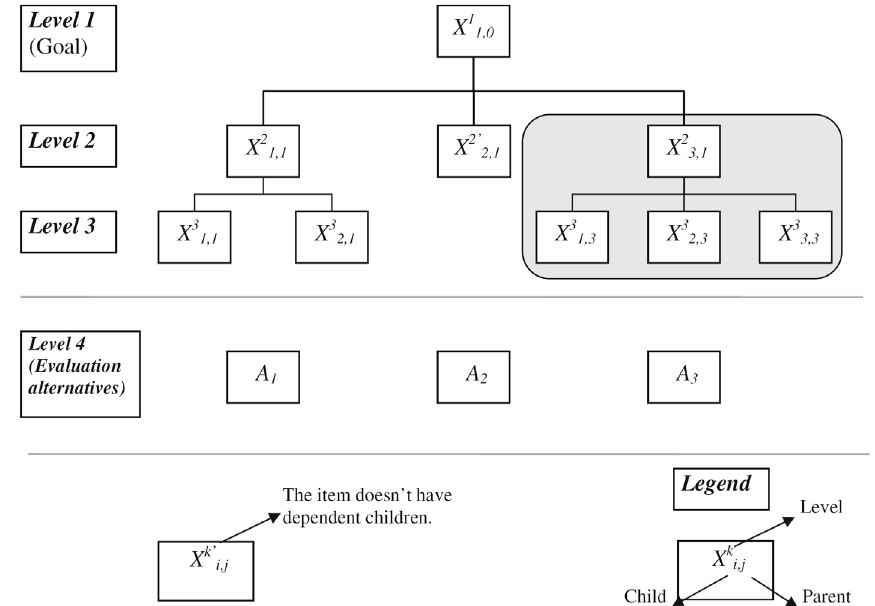
Figure 5. Decision hierarchical structure for a four-level problem decomposition, modified from Sadiq et al. [38]. Copyright 2004 IWA Publishing. The levels can be reduced to 3 or more than 4 depending on the complexity of the criterion